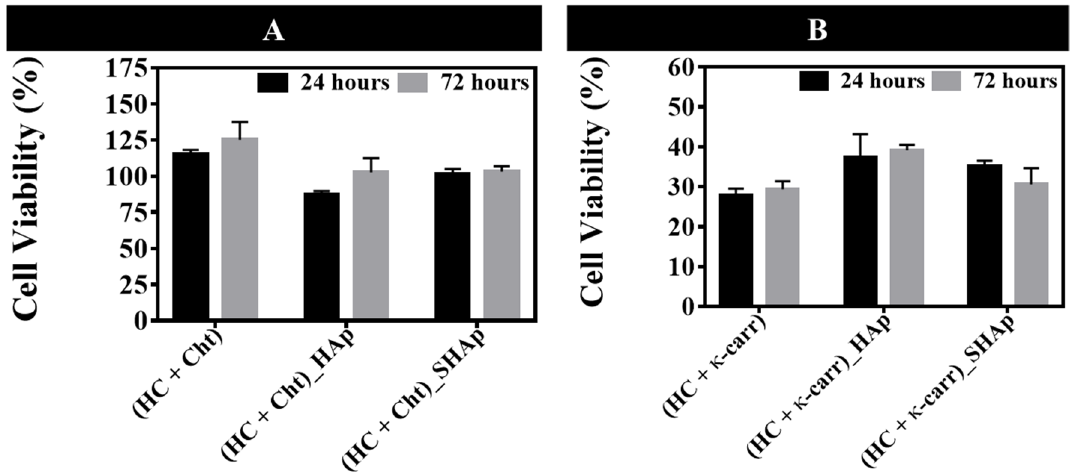
Figure 5. Effect of the membranes on in vitro osteoblasts culture. Osteoblast cell viability (as compared to the control: cells cultured on polystyrene discs) in the presence of the membranes based on hydrolyzed collagen (HC) and ( A ) chitosan (Cht) ((HC + Cht), (HC + Cht)_HAp, and (HC + Cht)_SHAp), and hydrolyzed collagen (HC) and ( B ) κ‐ carrageenan ( κ‐ carr) ((HC + κ‐ carr), (HC + κ‐ carr)_HAp, and (HC + κ‐ carr)_SHAp), containing 5 mg of AgNPs per 100 cm 2 of membrane.